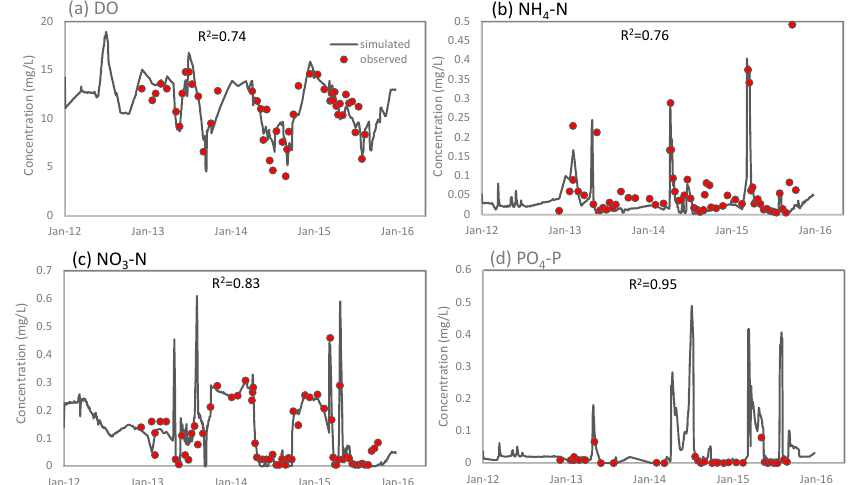
Figure 7. Calibration (2014–2015) and validation (2012–2013) results for simulated versus observed water quality data ( a ) DO (dissolved oxygen); ( b ) NH 4 -N; ( c ) NO 3 -N; and ( d ) PO 4 -P at Tugaske Bridge.